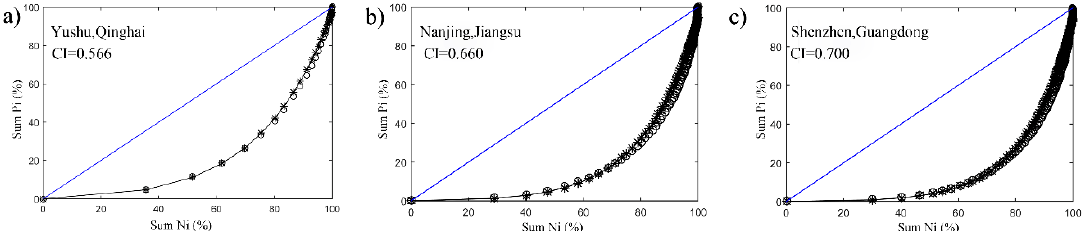
Figure 2. Empirical values based on the precipitation from 1961–2012 and Lorenz curves given by Equation (1) for the three grid cells: ( a ) Qinghai, ( b ) Nanjing, and ( c ) Shenzhen.